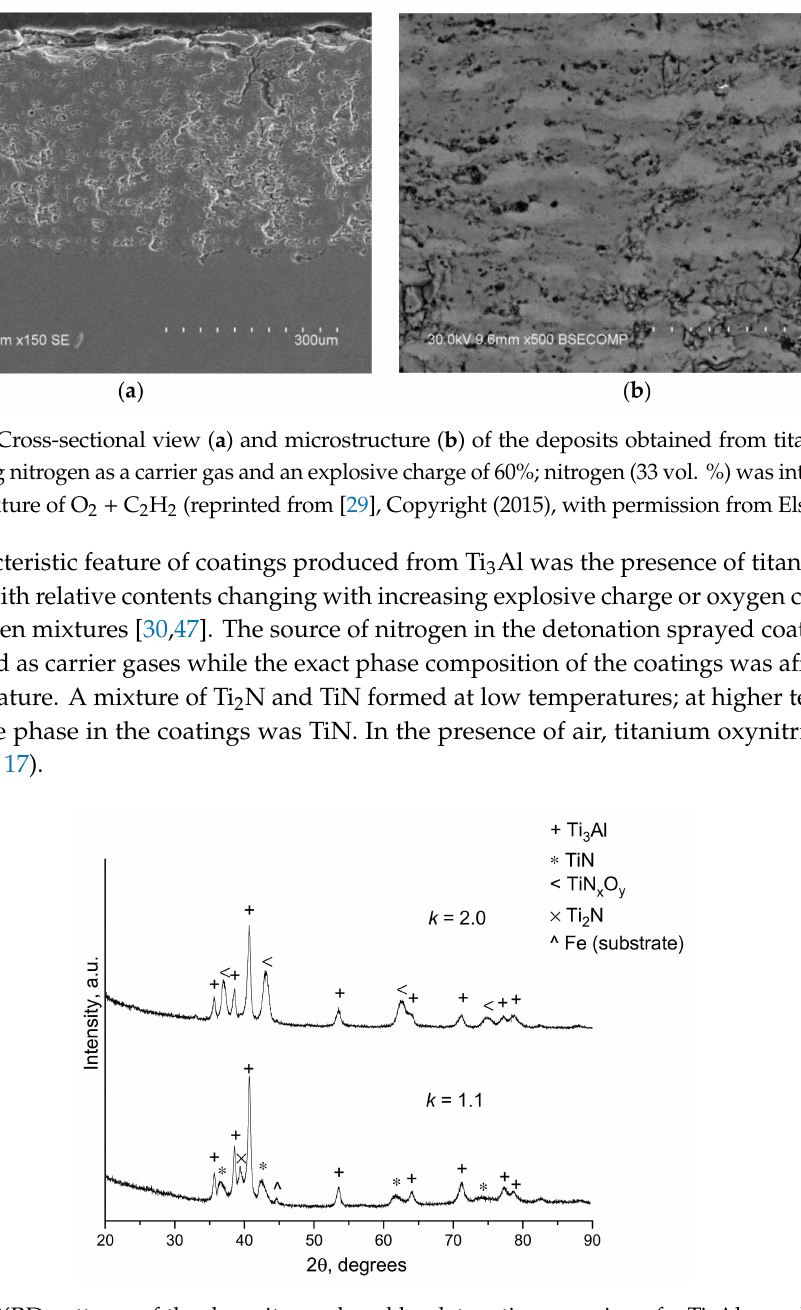
Figure 17. XRD patterns of the deposits produced by detonation spraying of a Ti 3 Al powder at an explosive charge of 40%, k = 1.1 and k = 2, carrier gas—air